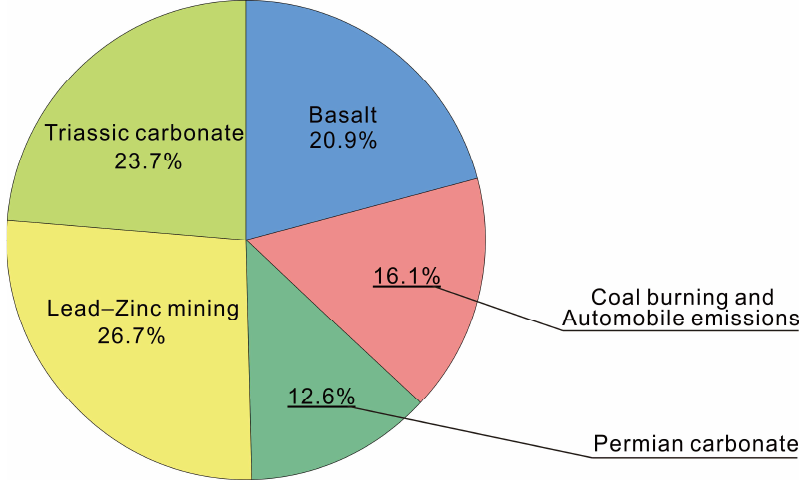
Figure 8. Contributions rates of different sources by